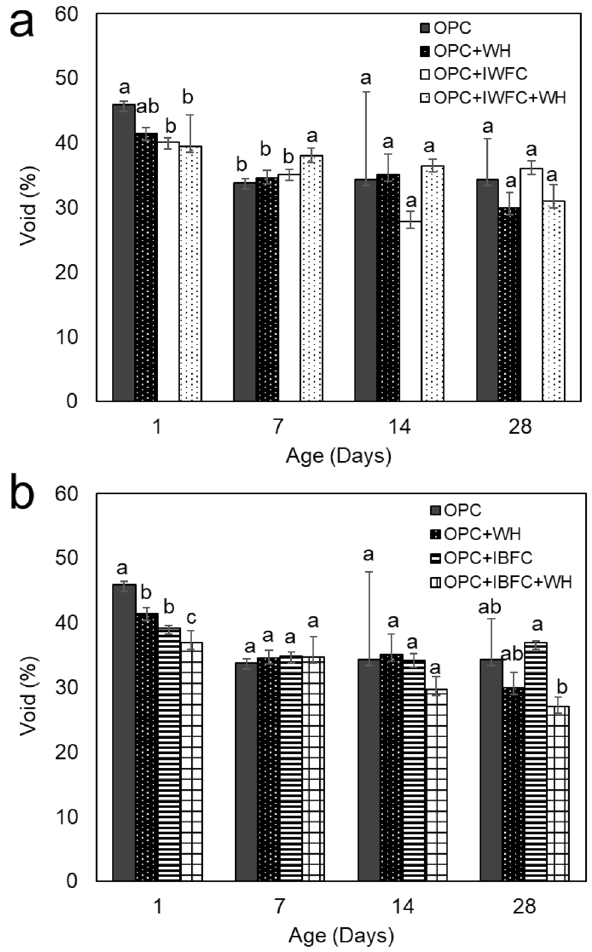
Figure 4. Void (%) of cementitious composites containing IWFC ( a ) and IBFC ( b ). Error bars represent standard deviations of the data. Different letters above the bars indicate significant difference at p -value < 0.05 when compared using the Least Significant Difference method (LSD). Data with different letters are significantly